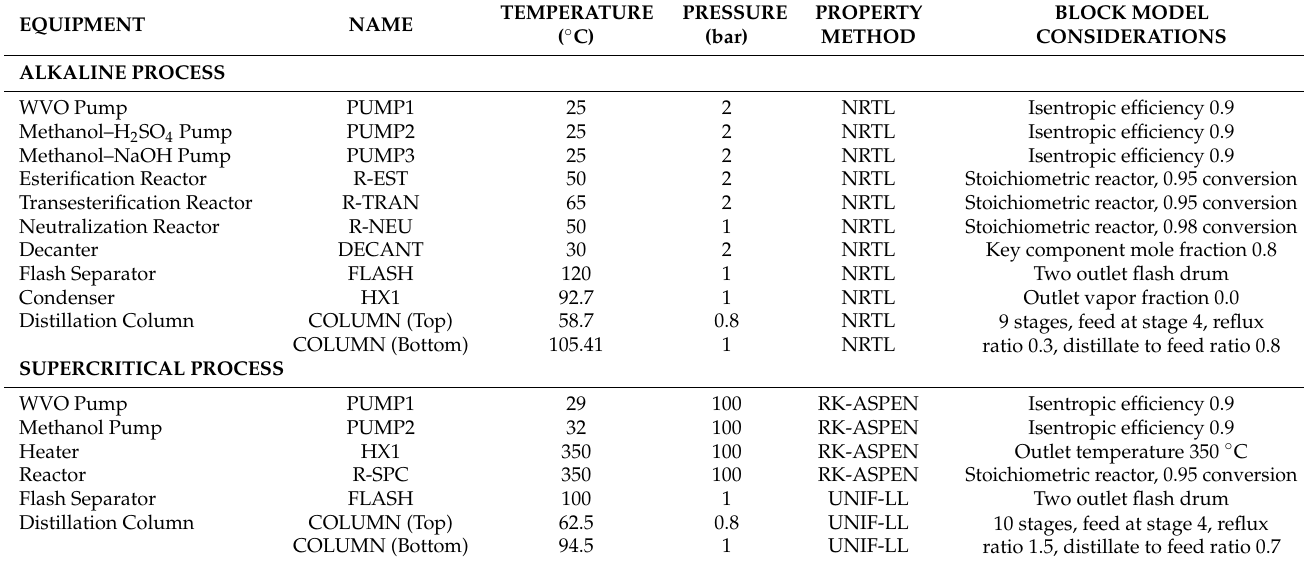
Table 1. Operating conditions and considerations for simulations